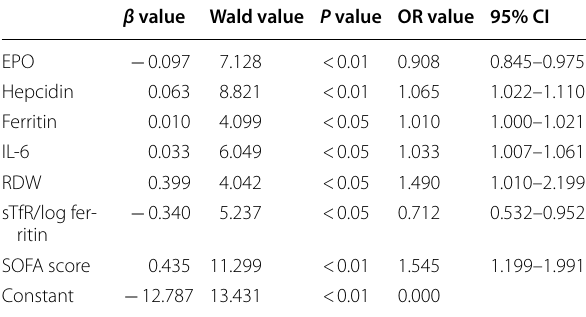
CI confidence interval; EPO erythropoietin; ICU intensive care unit; IL - 6 interleukin-6; OR odds ratio; RDW red blood cell distribution width; SOFA Sequential Organ Failure Assessment; sTfR soluble transferrin receptor